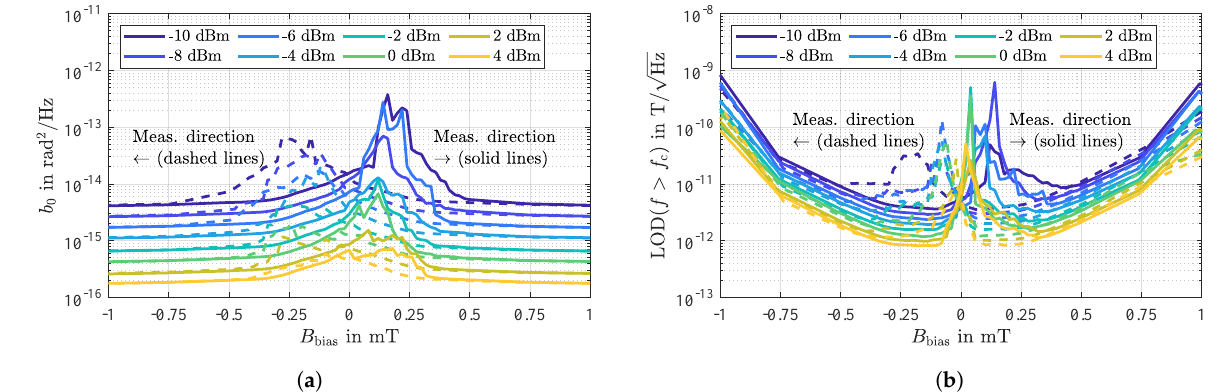
Figure 11. ( a ) Measured white phase noise b 0 as a function of the ambient bias magnetic flux density B bias and for various input power levels P 0 . The measurements were performed at the sensor’s synchronous frequency of f 0 = 144.8MHz and reveal the general trend of decreasing white phase noise for increasing input power levels. For magnetic flux densities around B = 0 additional magnetically induced insertion losses occur that lead to increased white phase noise. ( b ) Calculated limit of detection in the white noise regime according to Equation (19). The underlying phase sensitivity is shown in Figure